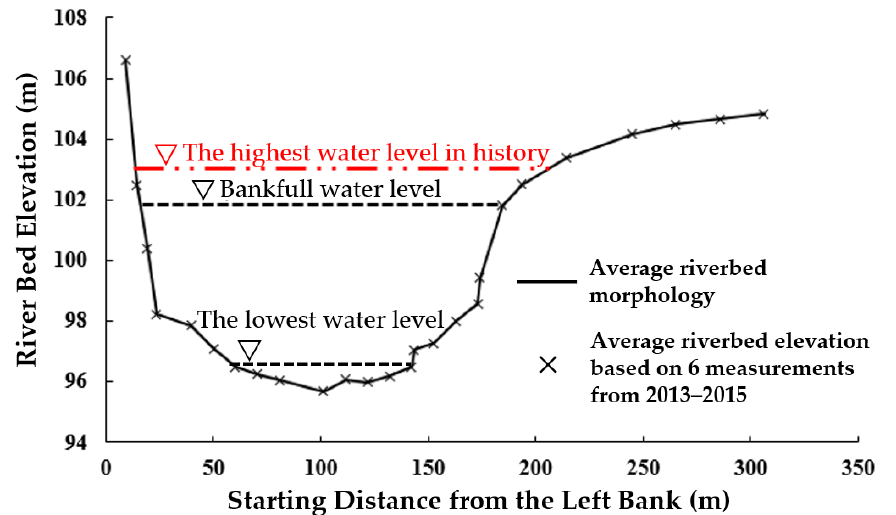
Figure 2. Average cross-section morphology of the Shagedu hydrological station.